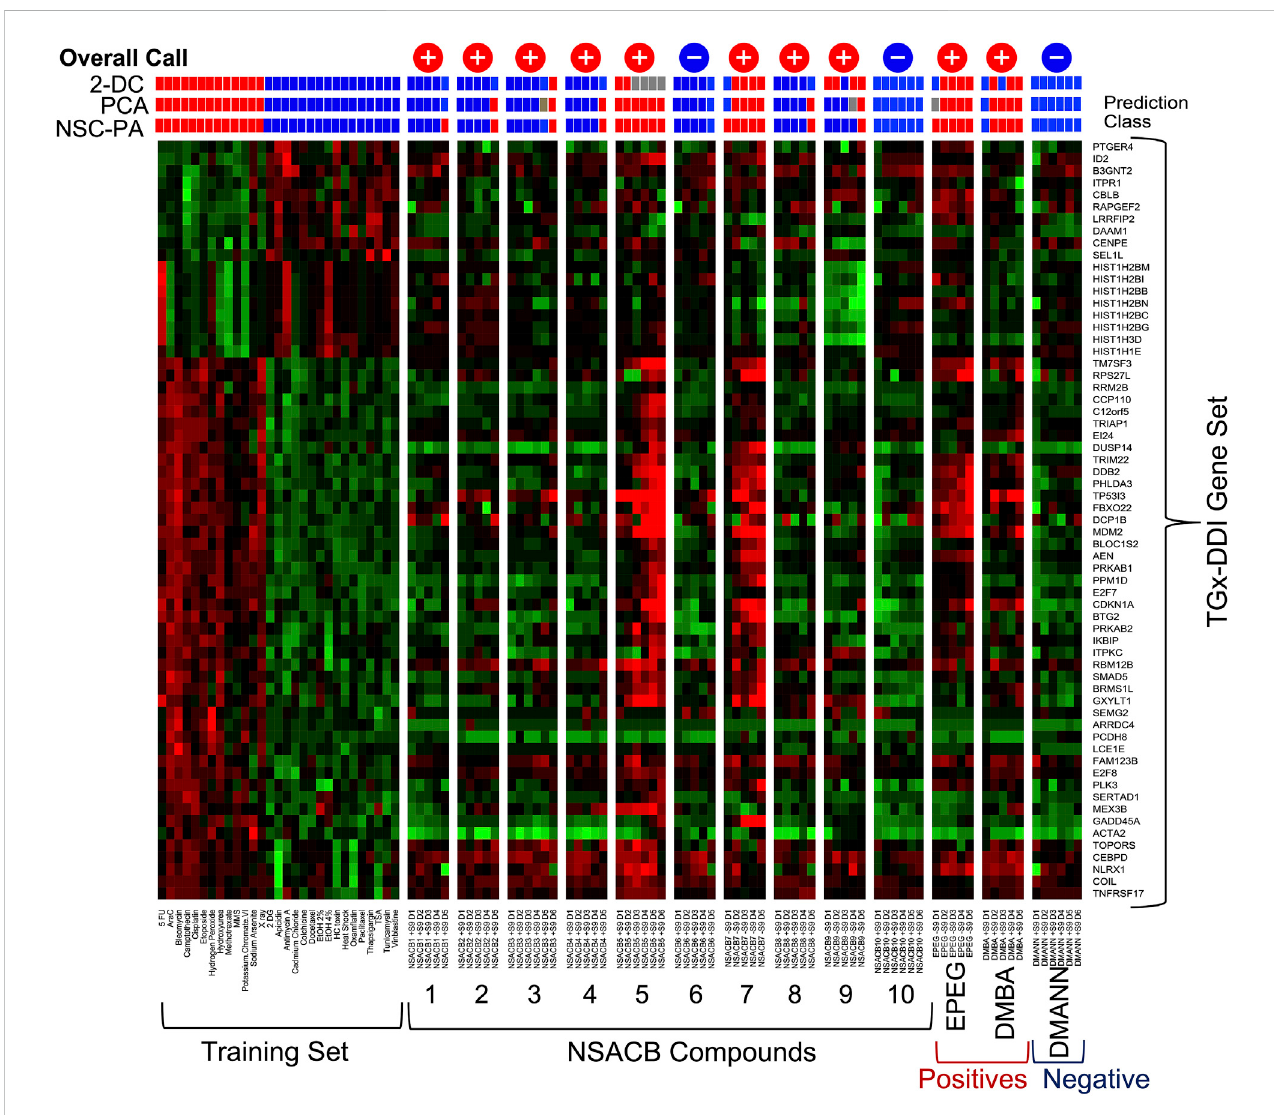
FIGURE 1 TGx-DDI classi fi cation of NSACB data-poor compounds. The heatmap on the left depicts the 28 reference chemicals used as a training set to generate thebiomarker.Thecolorscaleindicatestheaveragegeneexpressionfoldchangesoftworeplicatesrelativetosolventcontrol:up-regulatedgenesareshown in red, down-regulated genes are shown in green, genes with no change are shown in black. Three analyses: 1) 2-dimensional hierarchical clustering (2-DC), 2)principalcomponentanalysis (PCA),and3)nearestshrunkencentroidprobabilityanalysis(NSC-PA)wereusedtodetermineclassi fi cationprobabilities shown for all treatment conditions using red (DDI), blue (non-DDI), and grey (inconclusive) boxes. The overall calls are also shown at the top of each column: “ + ” signi fi es a positive DDI call, “ − ” signi fi es a non-DDI call. D1 represents the lowest concentration tested, D6 the highest. Cytotoxic concentrations ( <